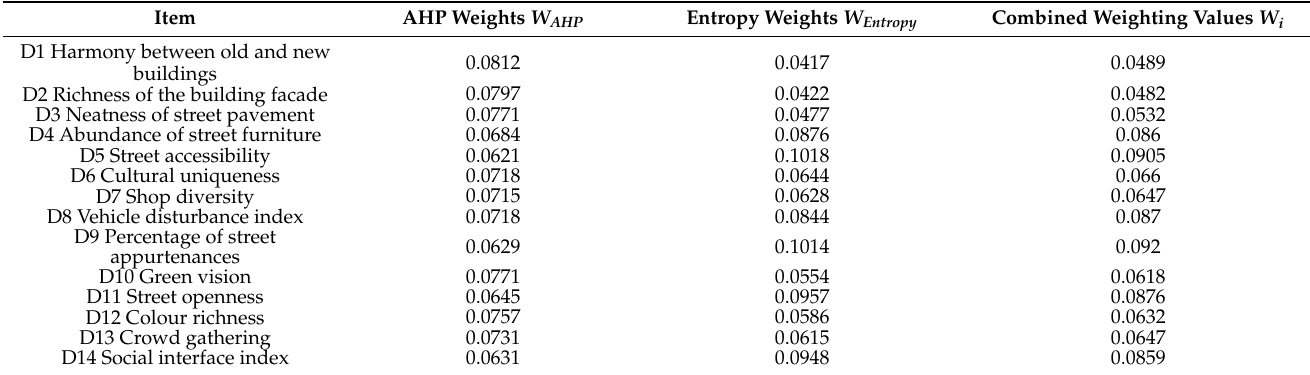
Table 7. Combined weighting values for indicator